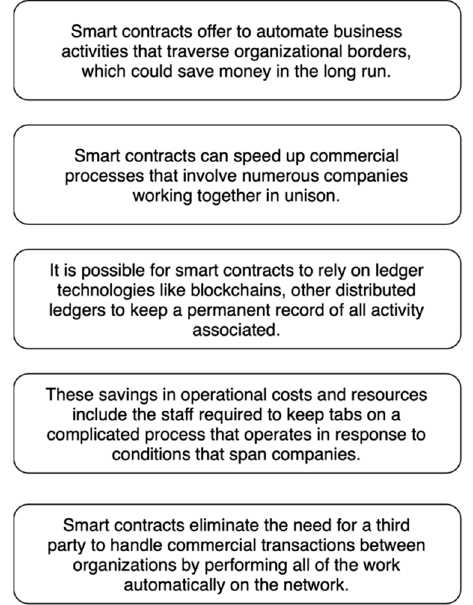
Figure 4. Benefits of Smart Contracts .